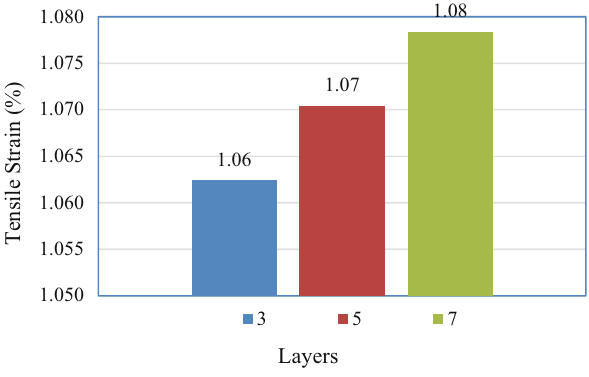
Figure 9: Comparison of average strain of di ff erent layers of bamboo laminate.